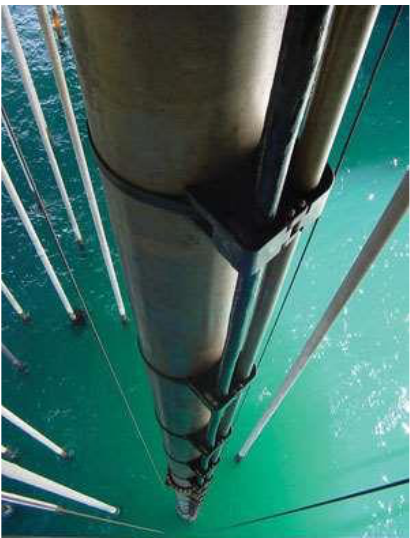
Figure 17. Composite drilling riser for offshore oil drilling: 15 m long, 59 cm inside diameter, 315 bar pressure; manufactured for Norske Conoco A/S and other oil companies (reprinted with permission from Ref.